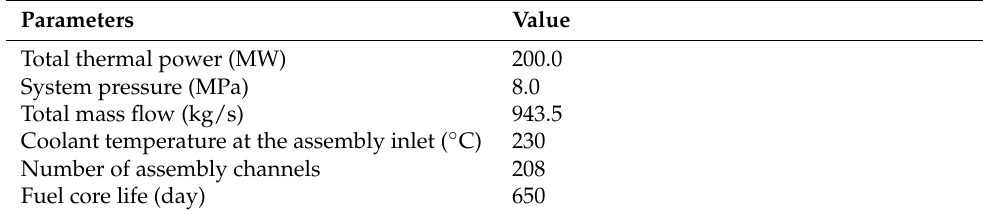
Table 2. Main parameters of the tested reactor.